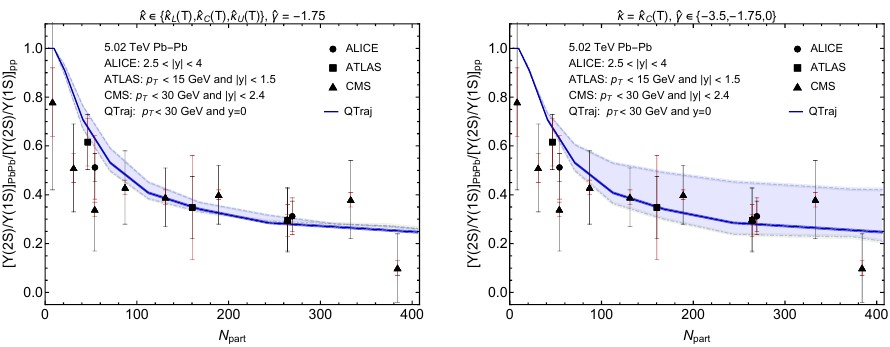
Figure 2. (Color online) The double ratio of the nuclear modification factor R AA [ Υ (2 S )] to R AA [ Υ (1 S )] as a function of N part compared to experimental measurements of the ALICE [23], ATLAS [24], and CMS [31] collaborations. The bands indicate variation of ˆ κ ( T ) and ˆ γ as in Fig. 1. The black and red experimental error bars represent statistical and systematic uncertainties,